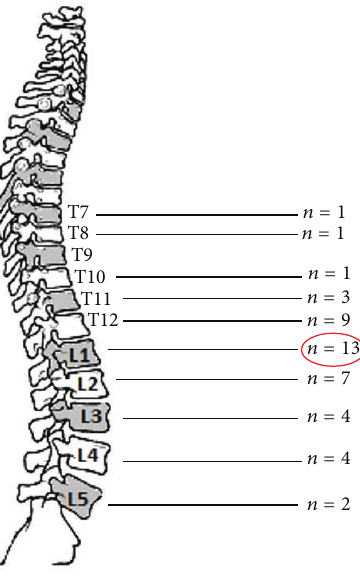
Figure 2: The total number of fractures that appeared in each level. L1 showed the greatest possibility for fracture